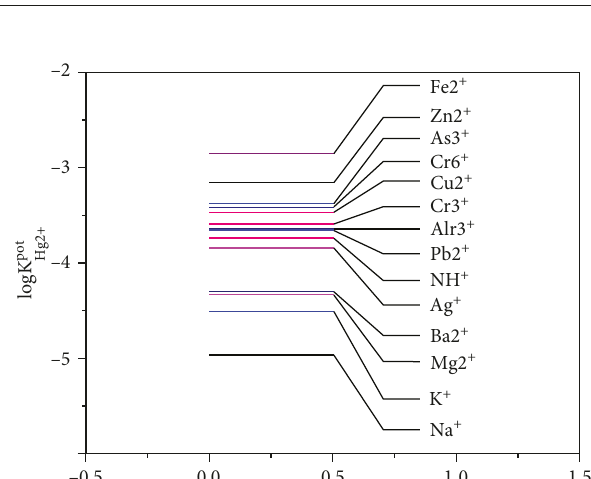
2+ TFPB-TZT to Hg